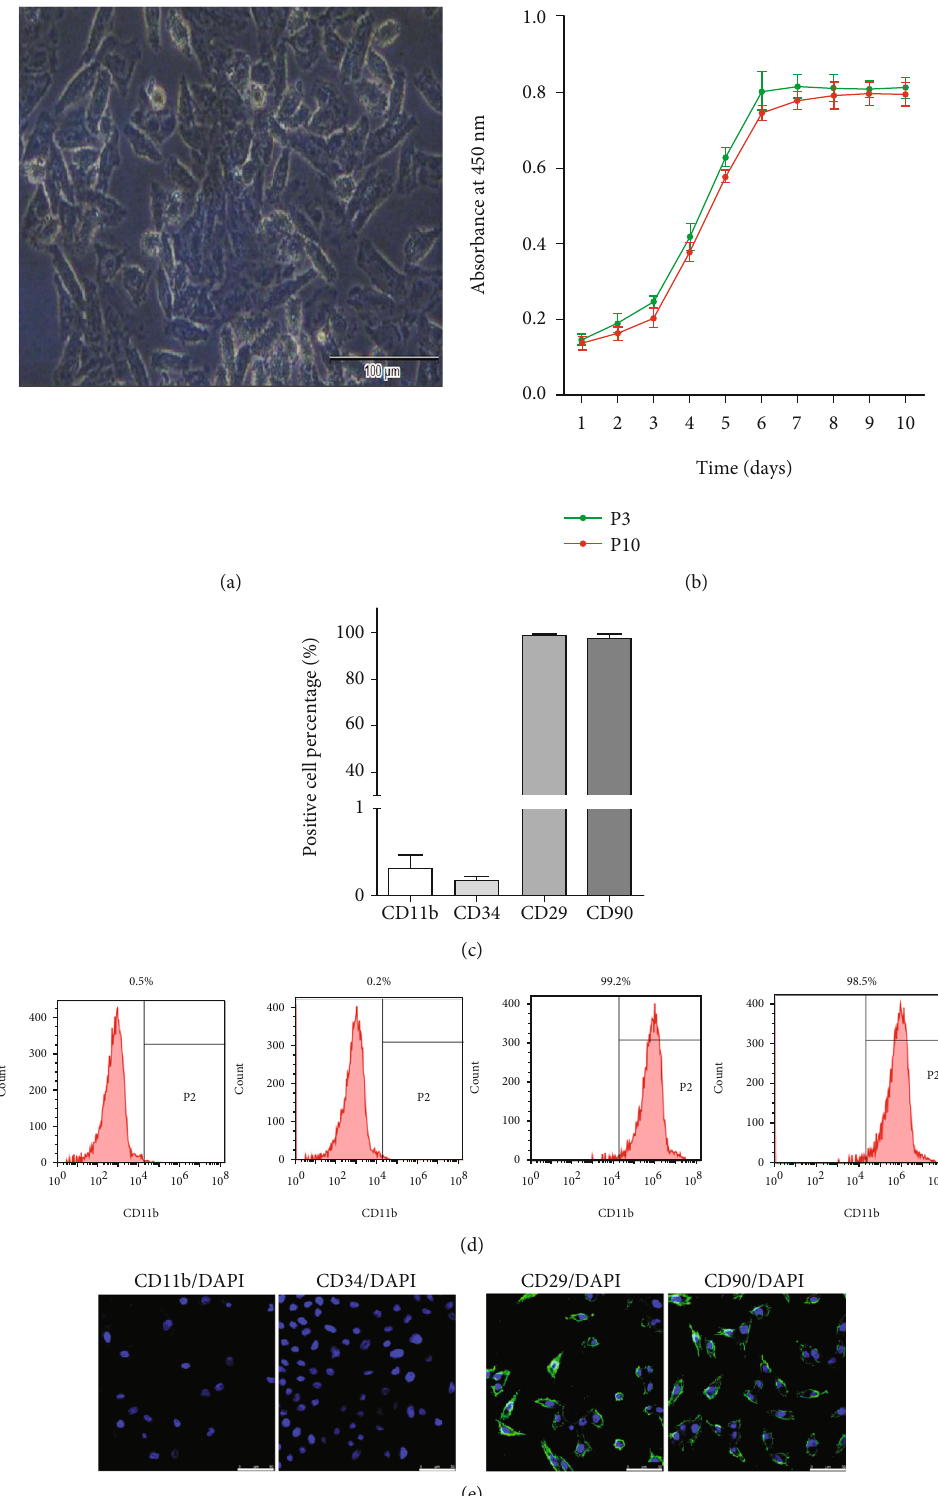
Figure 1: Identi fi cation of rabbit adipose-derived mesenchymal stem cells (ADMSC). (a) Representative images of the tenth (right, scale bar: 25 μ m) generation rabbit ADMSC under an optical microscope; (b) draw the growth curve of ADMSC by CCK8 assay kit. P3: third generation ADMSC; P10: tenth generation ADMSC; (c) fl ow cytometry was used to analyze the cell surface markers of ADMSC and the statistical comparison of the data; (d) the representative fl ow cytometry picture; (e) cellular immuno fl uorescence was used to analyze the cell surface markers of ADMSC. Scale bar: 50 μ m; data was expressed as ( SD ± mean ), and each analysis was repeated at least 3 times